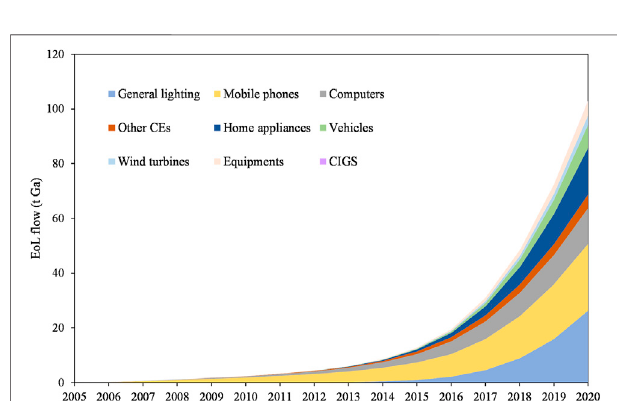
FIGURE 9 | Dynamics of end-of-life gallium fl ows in China during 2005 – 2020.